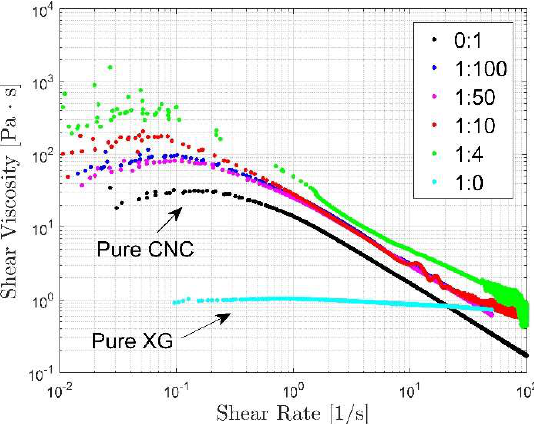
Figure 2. Viscosity measurements of mixtures of XG and CNCs at different ratios showing the influence of XG content on the overall viscosity and the shear thinning behavior of CNCs. Legend indicates the ratio of XG:CNC.